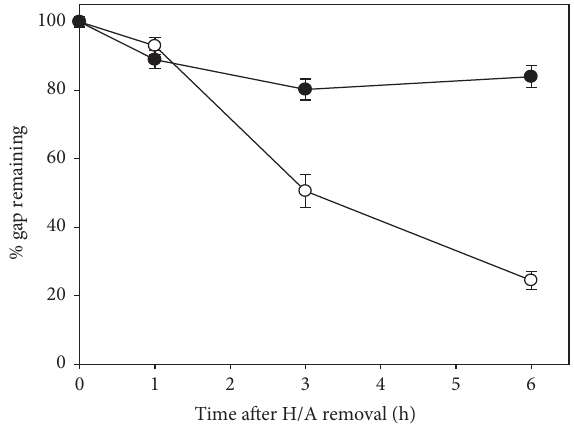
Figure 4: The effect of PCNA knockdown on gap-filling during repair of UV-induced DNA lesions. Similar to the procedures described in Figure 1, yet colcemid was excluded to avoid “overde- lay.” AGS cells were stably transfected with pLKO-1 shPCNA to knock down PCNA (closed circles) or control vector (open